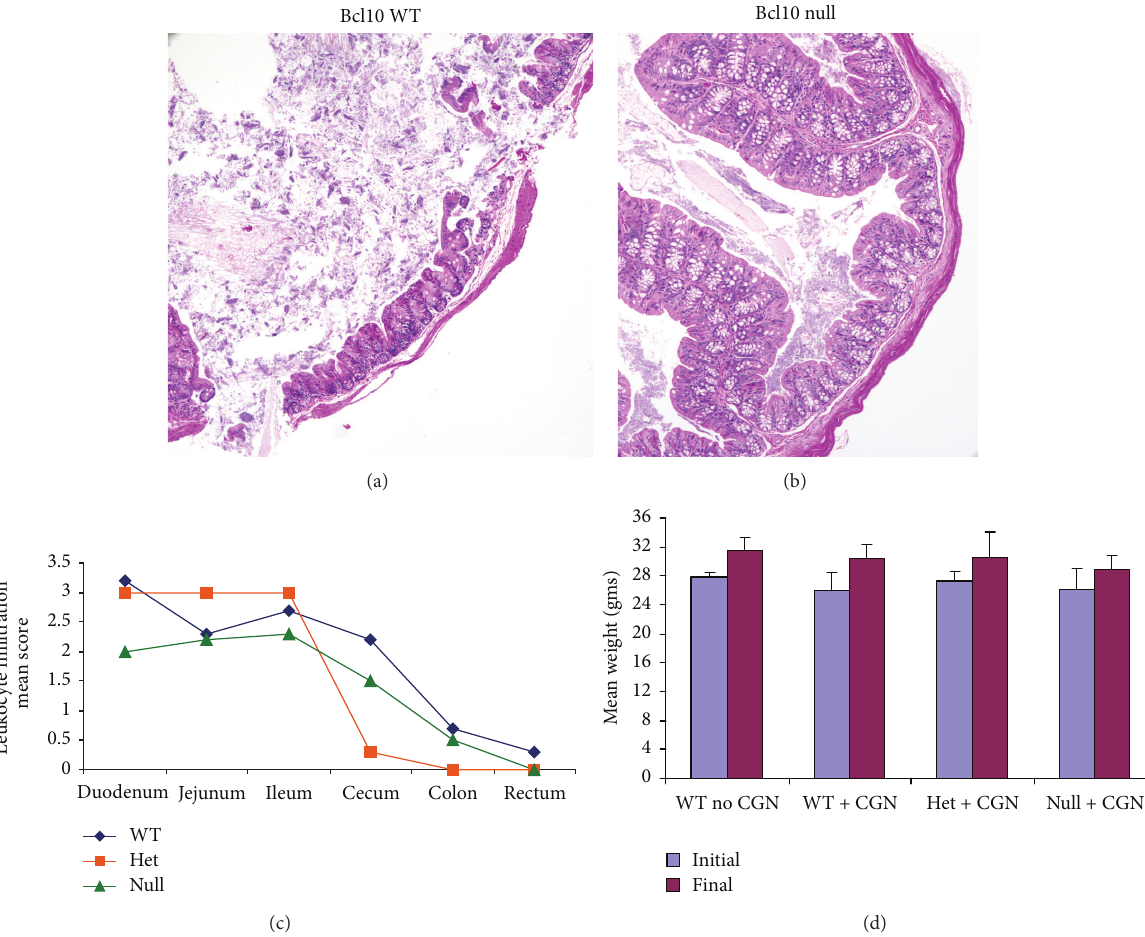
Figure1:HistopathologyofintestinaltissueinBcl10wildtypeandnullmicefollowingcarrageenanexposure.(a),(b)Bcl10WT,heterozygous, and null mice were sacrificed after ingestion of carrageenan (10 𝜇 g/mL) added in their water for 30 days. Histopathology of H&E sections of cecum demonstrated disruption of the mucosa in a WT mouse, with no similar findings in the Bcl10 null mice, consistent with reduced inflammation in the absence of Bcl10 [WT: wild type]. (c) Throughout the mouse intestine, the extent of inflammatory infiltrate, including granulocytes, lymphocytes, and plasma cells, was greater in the Bcl10 WT mice, than in the Bcl10 null mice. The histopathology was scored for 3WT, 3 heterozygous, and 3 null mice, and the mean scores for leukocyte infiltration for each site are compared. The scores for the WT mice are higher at each site than for the null mice, although the differences are not statistically significant. The extent of inflammatory infiltrate was significantly greater in the small intestine than in the colon and rectum for each of the groups ( 𝑃 < 0.01 ). Cecal inflammation, including leukocyte infiltration and edema, was greater in the WT mice than in the heterozygous or null mice. (d) The mouse weights at the onset of the carrageenan exposure and at termination are presented and indicate no significant differences in weight and slight weight gain in all groups. ( n for no CGN control=3; n for WT with CGN = 6; n for het with CGN = 3; n for null with CGN = 8) (WT: wild type; het: heterozygous; CGN: